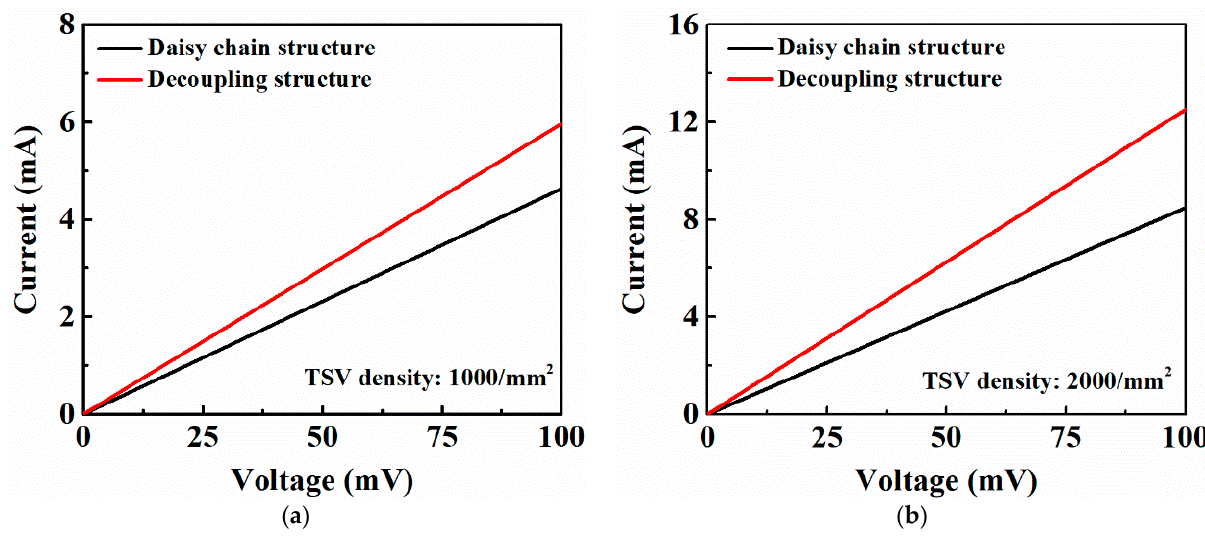
Figure 13. Typical I–V curves of the daisy chain structures and the decoupling structures with: ( a ) TSV density of 1000/mm 2 , ( b ) TSV density of 2000/mm 2 .